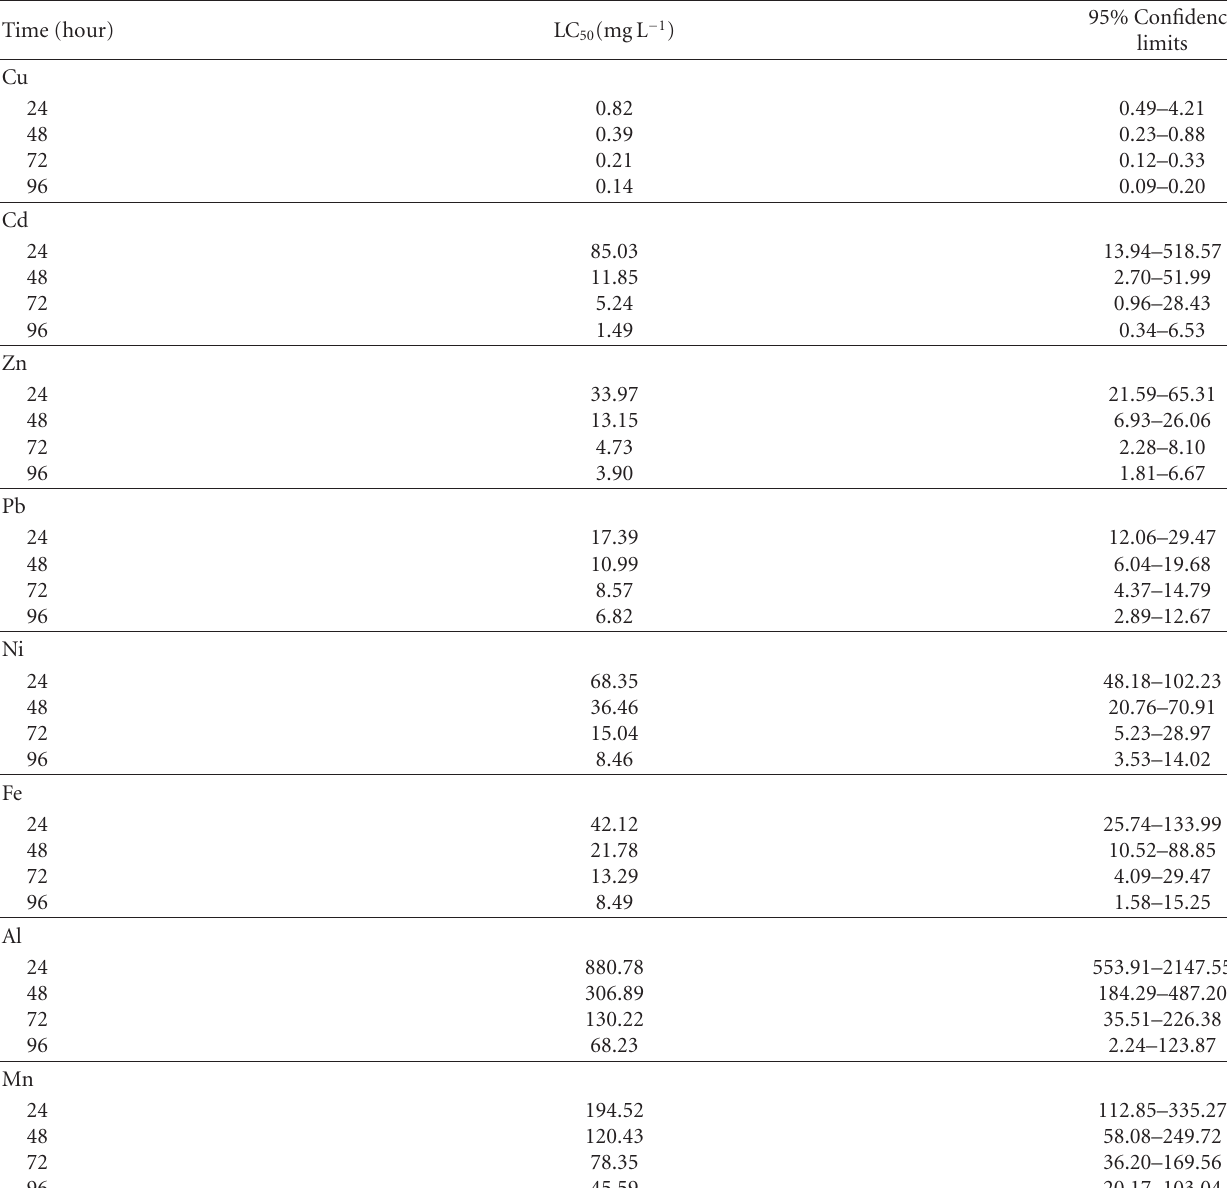
Table 2: Median lethal concentrations (LC 50 ) for M. tuberculata at di ff erent exposure times for Cu, Cd, Zn, Pb, Ni, Fe, Al, and